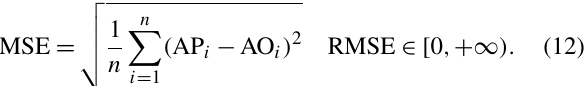
(y yr )) for a specific year, and y yr is the 1 2 3